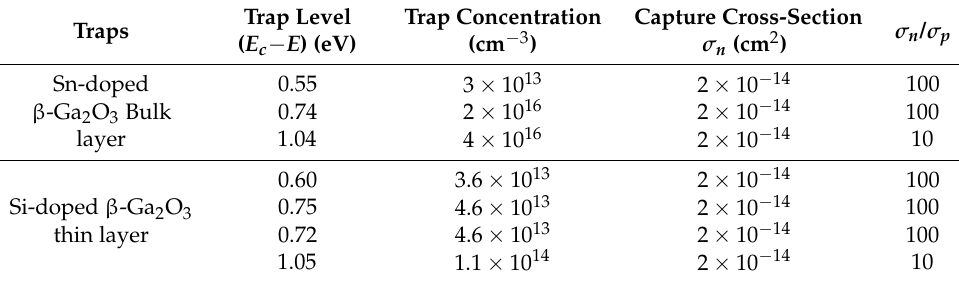
Table 2. Traps related to β -Ga 2 O 3 layers